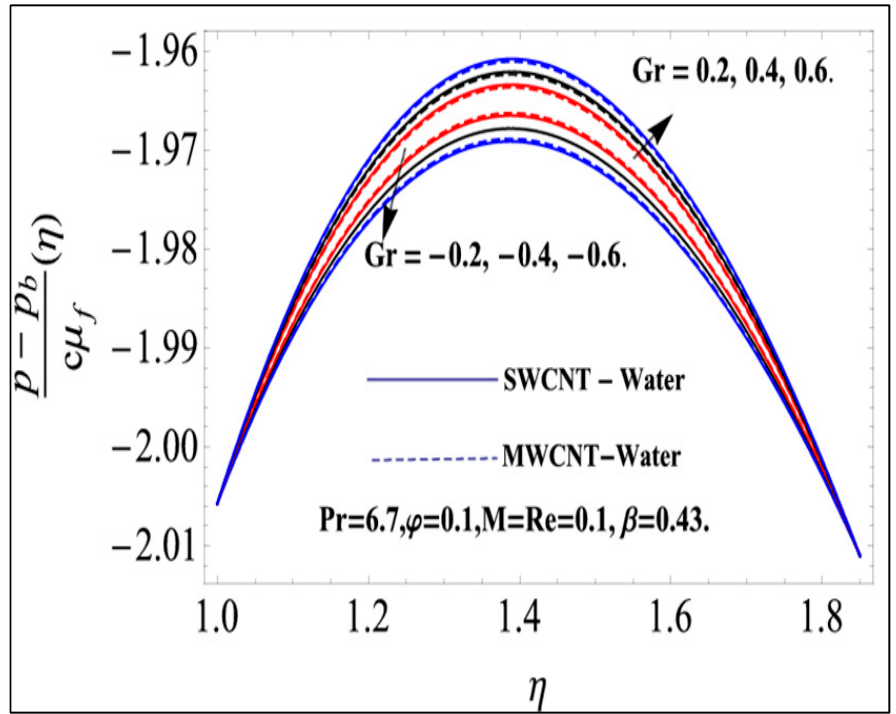
Figure 11. Impact of the positive and negative values of the G r on the pressure distribution.